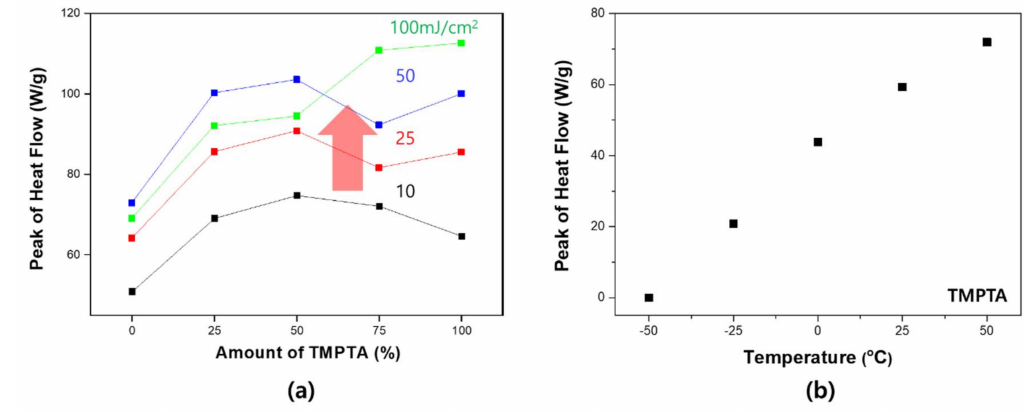
Figure 9. Heat flow of the binary monomer system in accordance with the UV intensity: ( a ) by UV intensity; and ( b ) by temperature.